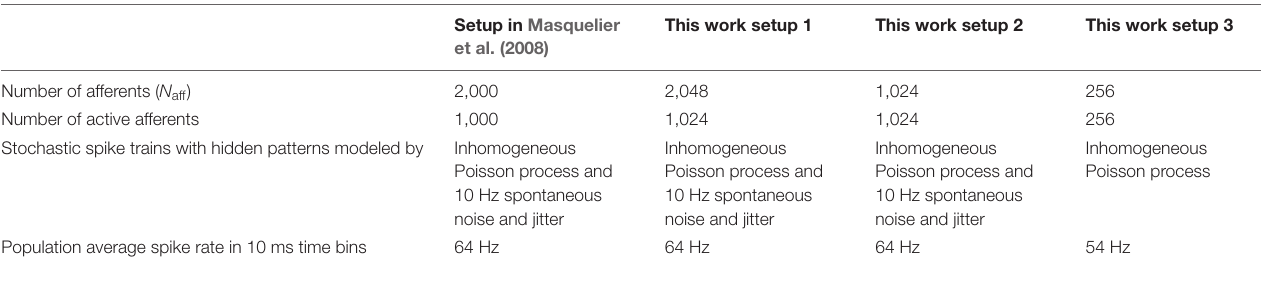
TABLE 1 | Experimental setups for pattern